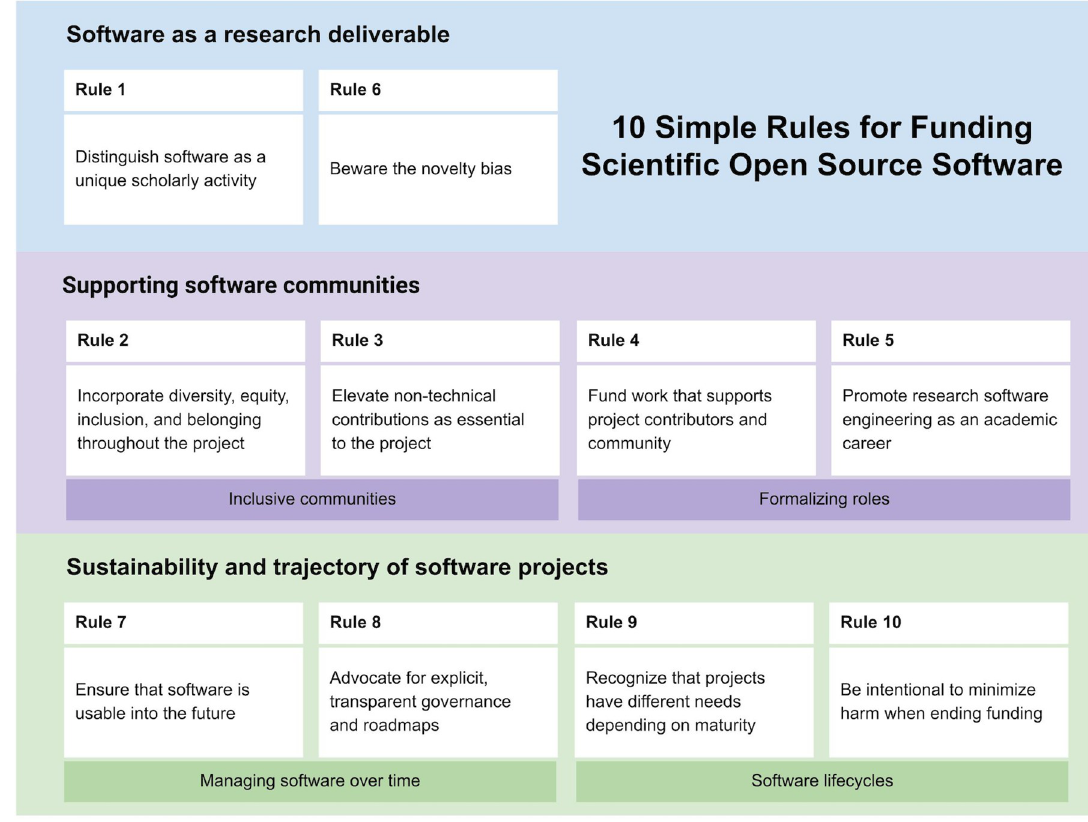
Fig 1. Ten simple rules for funding open source scientific software, grouped by themes. Numbers reference the order in which rules occur in the narrative.